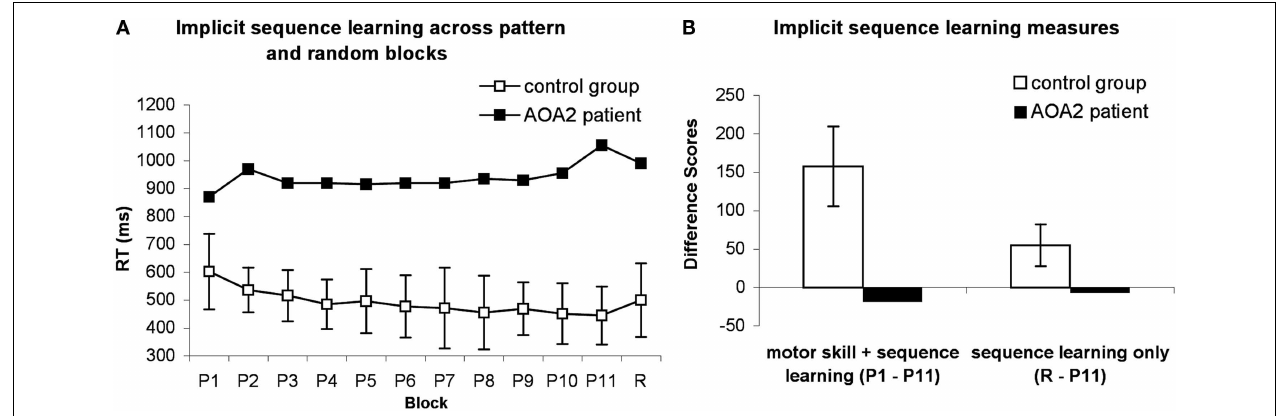
skill learning (P1-P11) and sequence learning (R-P11) are displayed. Error bars indicate standard deviations, computed for control group only. P, pattern; R, random.